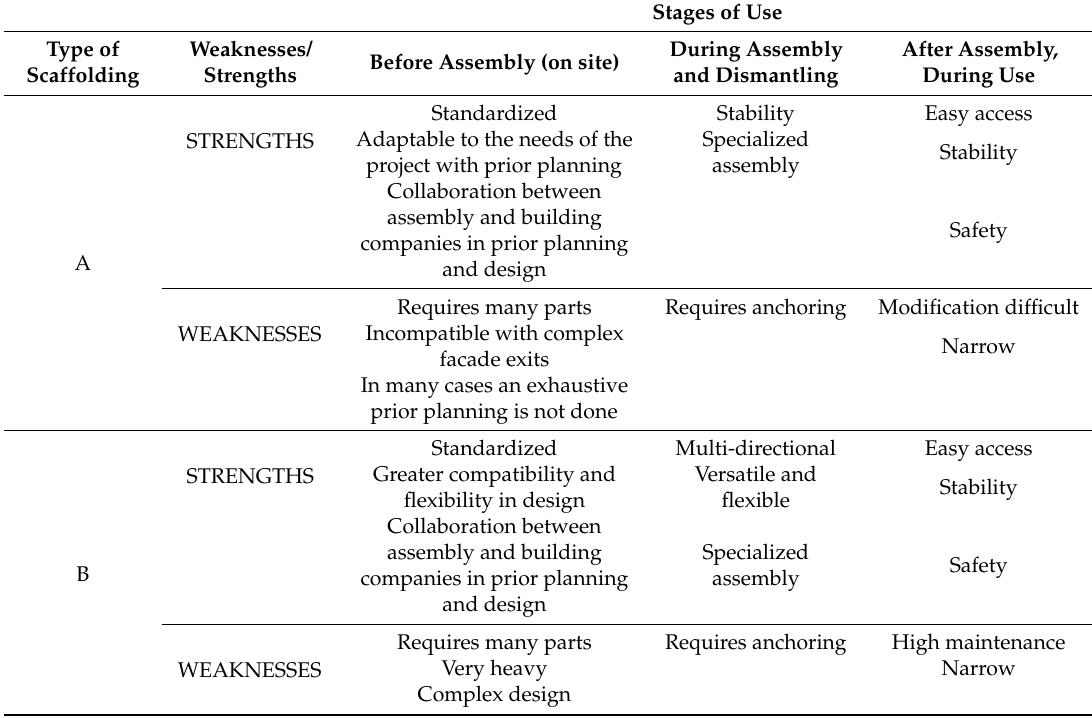
Table 4. Strengths and weaknesses of scaffolding systems in the different stages of their use. Stages of